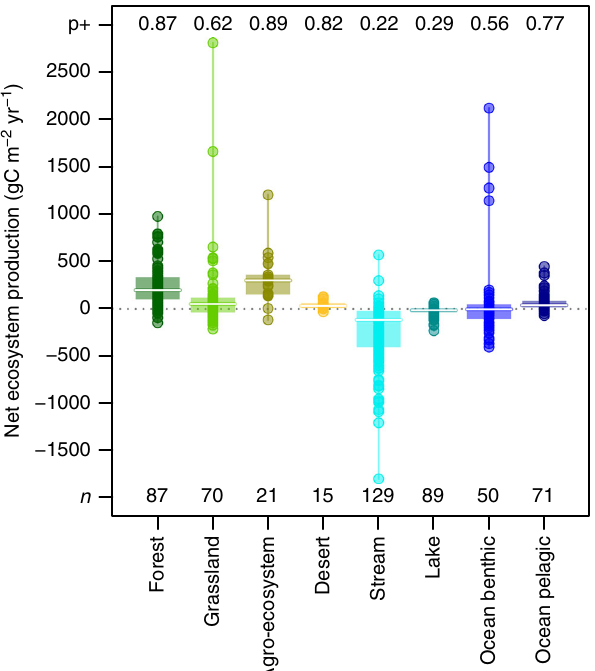
Fig. 4 Net ecosystem production for different ecosystem types. Net ecosystem production (NEP) corresponds to the balance between gross primary production and ecosystem respiration. Negative values denote net heterotrophic functioning. Circles give individual values in gC m − 2 year − 1 . Note that these are production fl uxes and not productivity rates (biomass turnover), for which we would have higher values in aquatic compared to terrestrial ecosystems. Boxplots give median (white line), 25 and 75% percentiles (box), and range (whiskers). Top numbers (p + ) give the probability of NEP being positive within each ecosystem type, assuming normal distributions of the data (quantile corresponding to 0). Bottom numbers ( n ) indicate the number of data points. The 95% con fi dence intervals for mean NEP within each ecosystem types are in gC m − 2 year − 1 : Forest [204; 301], Grassland [28; 224], Agro-ecosystem [197; 438], Desert [18; 70], Stream [ − 307; − 193], Lake [ − 32; − 14], Ocean benthic [ − 60; 201], and Ocean pelagic [47; 90] (see full results of two-sided t -test in Supplementary Table 1). A conservative non-parametric Kruskal-Wallis ’ test indicates signi fi cant differences among ecosystems ( χ 2 ¼ 275 : 04 ; P < 0 : 001). The post-hoc multiple comparisons test using 7 ; 532 rank sums gives the following groups: a, bc, a, abcd, e, d, bd, ac (lower case letters for grouping from left to right in the fi gure; see Methods)